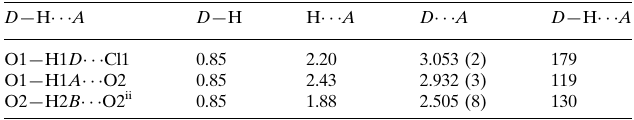
Hydrogen-bond geometry (A˚ , (cid:4)